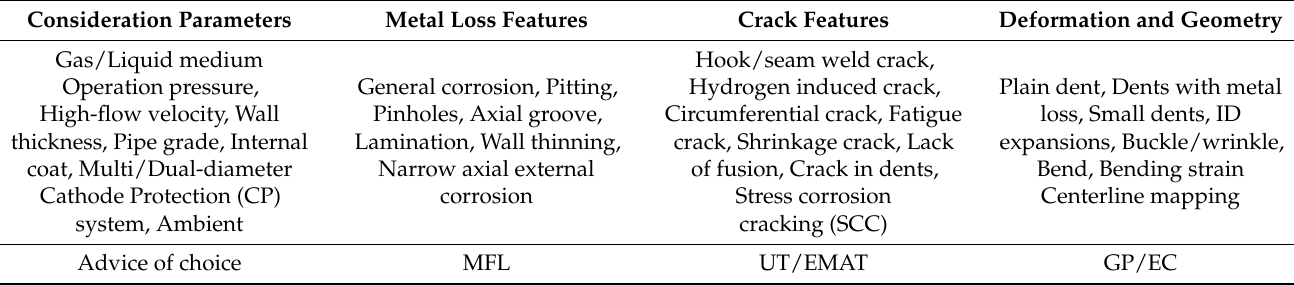
Table 5. Advice for the choice of commercial PIG. (Reprinted from ref. [110]).